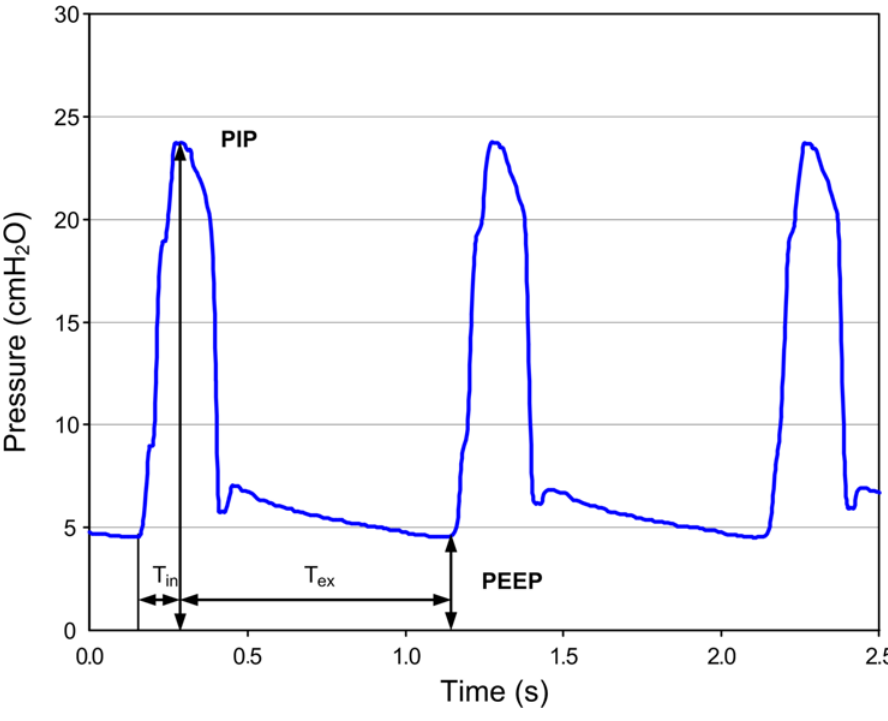
Fig 3. Pressure profile of a self-inflating bag with 8 l/min flow